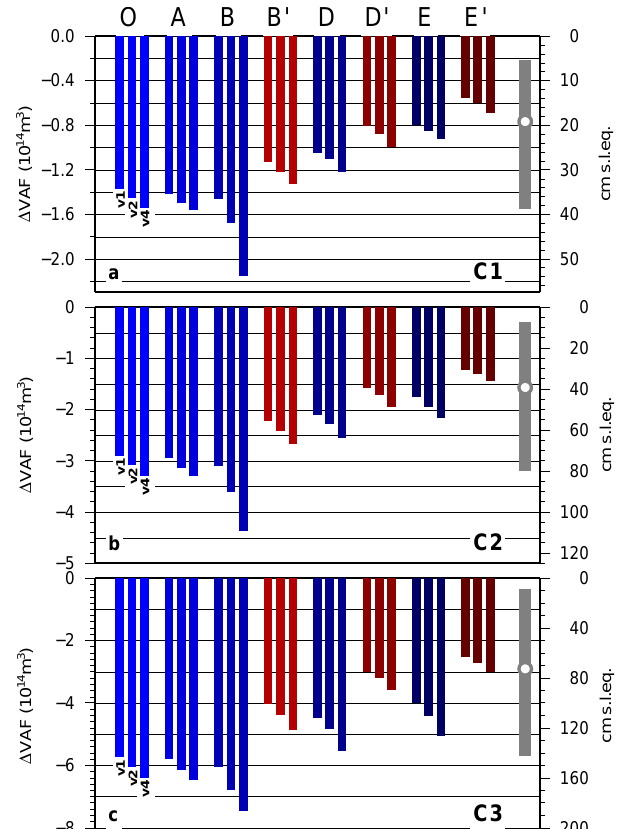
Figure 2. Simulated changes in VAF at 500 years from the present- day obtained by future-climate runs in terms of the difference rel- ative to the result of corresponding constant-climate experiments ( C0 ). The top, middle, and lower panels are results of C1 (A1B climate forcing), C2 (1 . 5 × A1B), and C3 (2 × A1B), respectively. Each panel contains the results of experimental configuration of O (IcIES SeaRISE compatible), A , B , B (cid:48) , D , D (cid:48) , E , and E (cid:48) . The three bars from left to right in each configuration correspond to the re- sults for v1 (using “standard” sliding coefficients), v2 (2 × ), and v4 (4 × ), respectively. The vertical gray bars at the right indicate the range of results summarized in SeaRISE (Bindschadler et al., 2013, Table 3) at 500 years. The circles in the gray bars indicate the mean values of all the SeaRISE